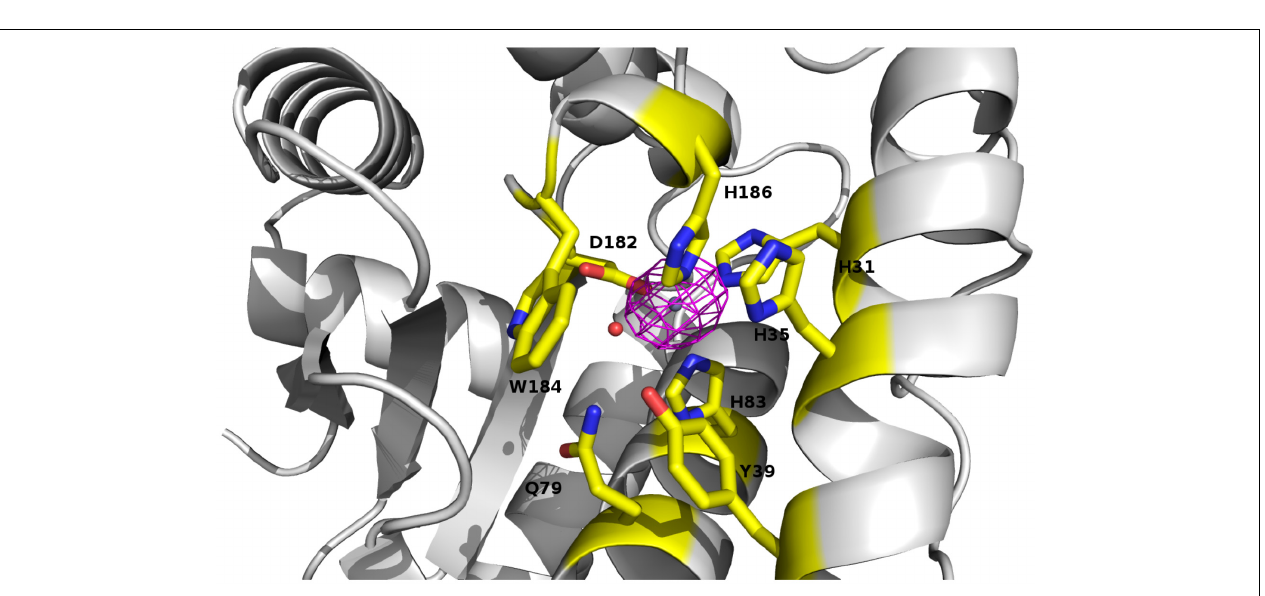
FIGURE 6 | View of the catalytic site of PAP9 superimposed with the anomalous electron density map calculated at the zinc K-edge. Residues of the catalytic site and closing the catalytic site are drawn in sticks. The zinc ion is drawn as gray sphere. The water molecule corresponding to the hydroxide ion is represented as a red